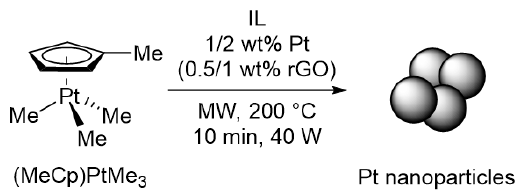
Table 1. Summary of Pt-NPs and Pt-NP@rGO in tunable aryl alkyl ionic liquids (TAAILs). Further information can be found in Table S1 in the Supplementary